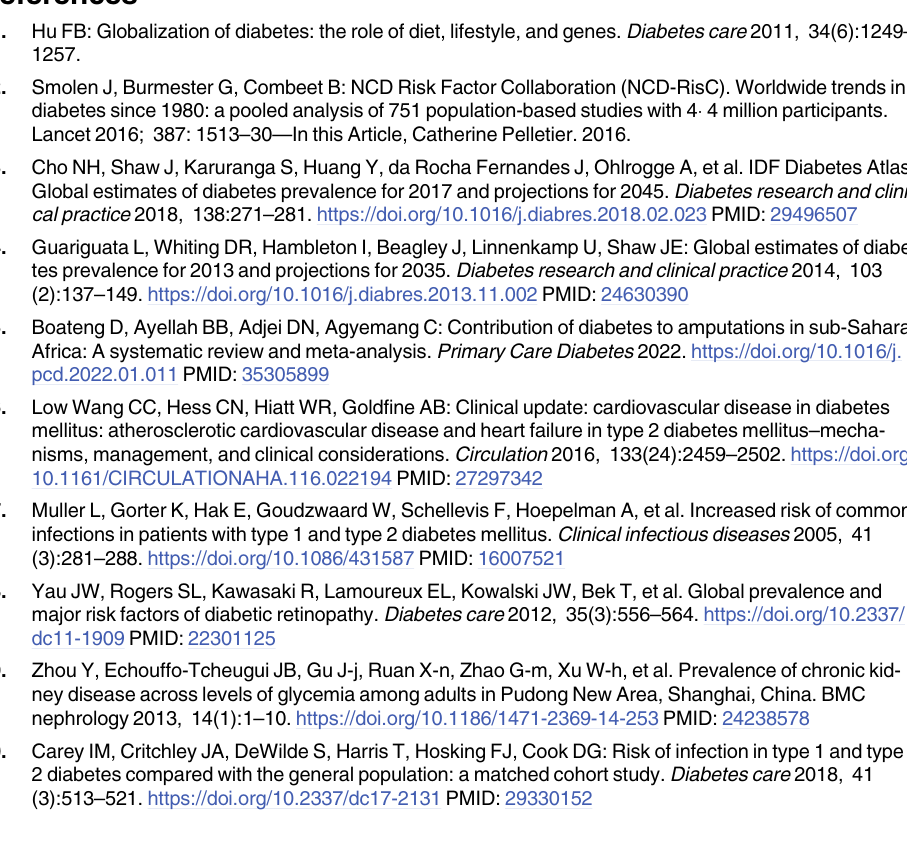
S2 Table. Risk of bias assessment for the included studies. The ten item questions of which four items assess external and six items assess internal validity were